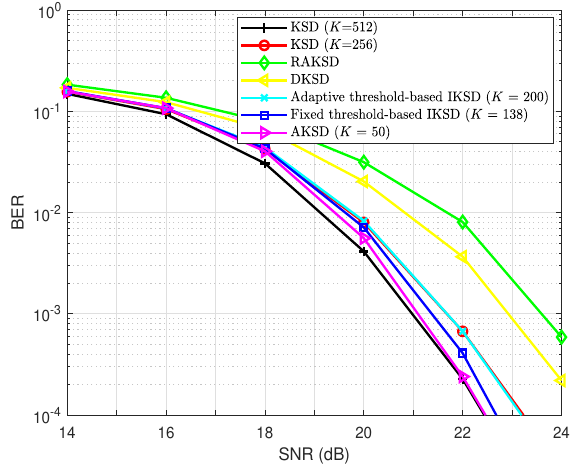
Figure 1. The BER performance comparison of KSD algorithms for a 48 × 48 MIMO system with